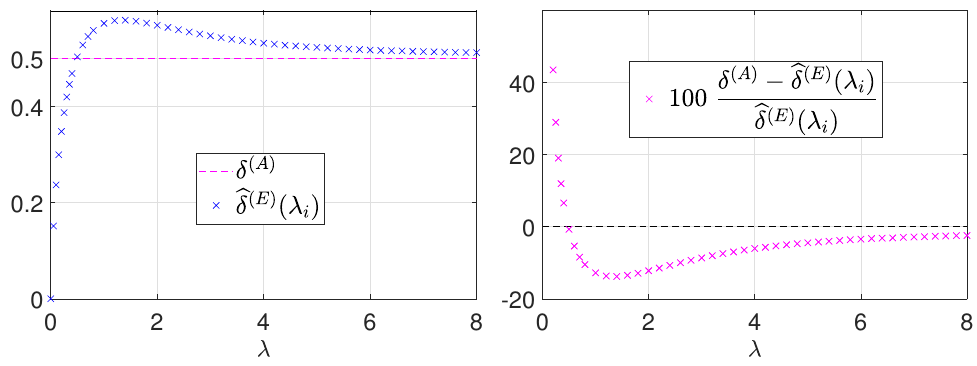
Figure 2. Comparison between the approximation δ ( A ) = 1/2 of δ ( E ) ( λ ) = E { F ( Y λ ) } used in the (15) proposed in [5,7] and the Monte Carlo estimates (cid:98) δ ( E ) ( λ i ) for some λ i ∈ [ 0,8 ]